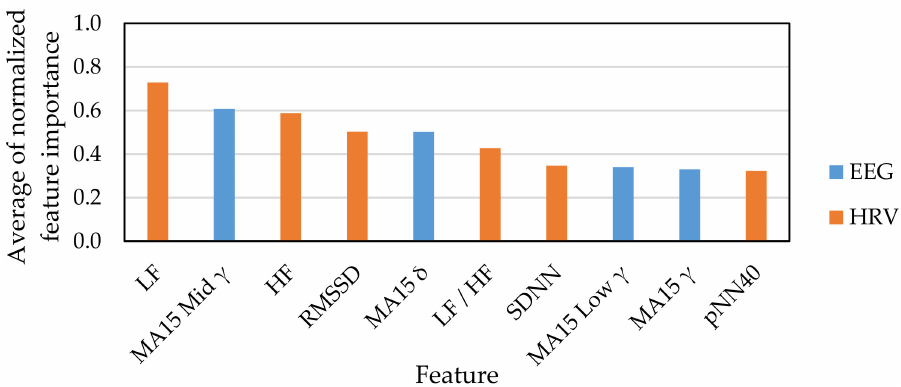
Figure 9. Feature selection result for low valence and high